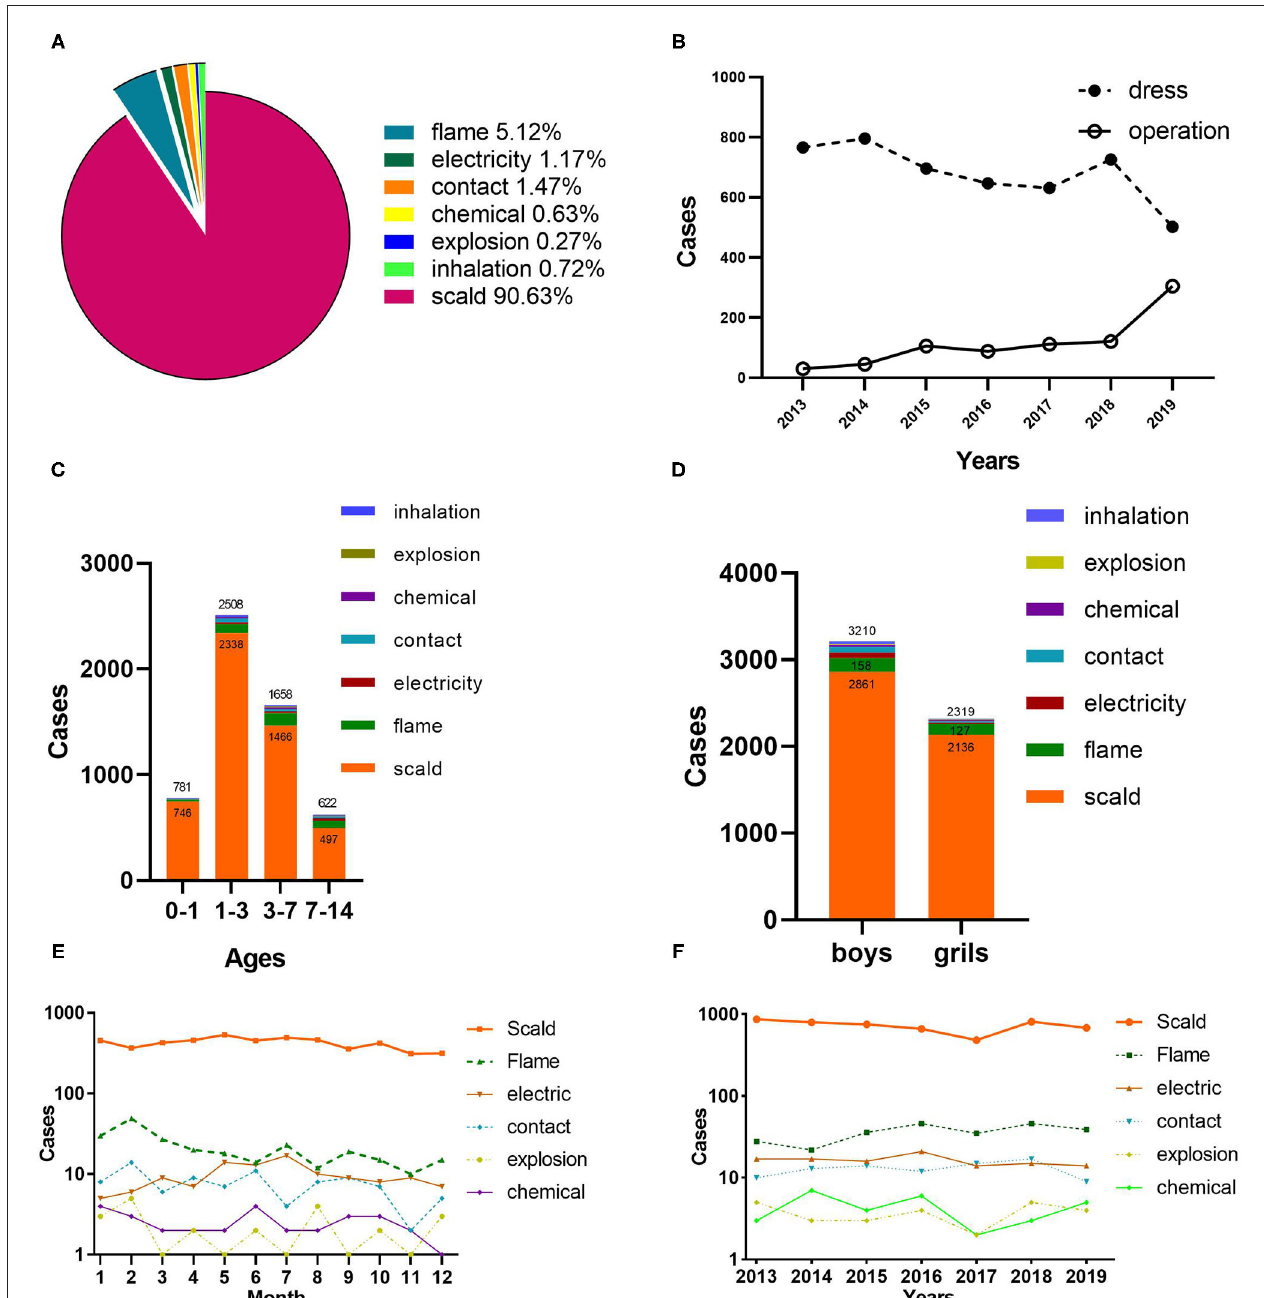
FIGURE 2 | Etiology analysis and therapeutic schedule. (A) The proportion of different causes of burns. (B) Therapeutic schedule by years. (C) Etiology distribution by age. (D) Gender distribution of etiology. (E) Month distribution of etiology. (F) Distribution of etiology by